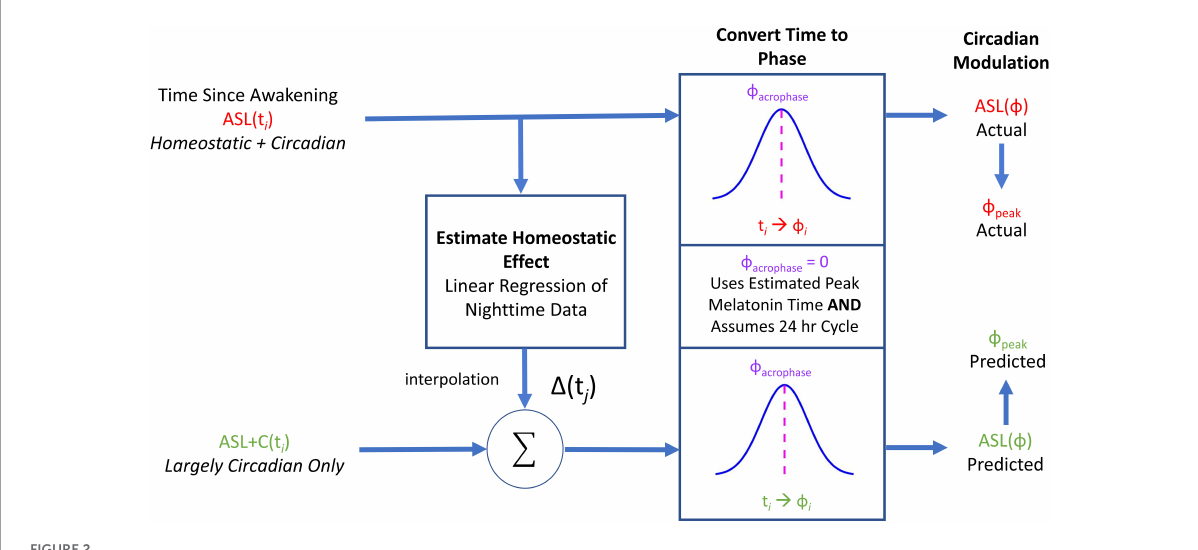
FIGURE2 A flowchart of the circadian phase computations for actual ASL and predicted ASL using ground recouped as the performance measure of interest. Predicted ASL was computed by adding the homeostatic estimate from the ASL data to the circadian estimate from ASL+C. This simulation analysis served as an internal self-consistency validation of our ASL phase estimates. The observed phase alignment from this analysis suggests that the circadian phase differences between ASL and ASL+C could largely be attributed to homeostatic sleep